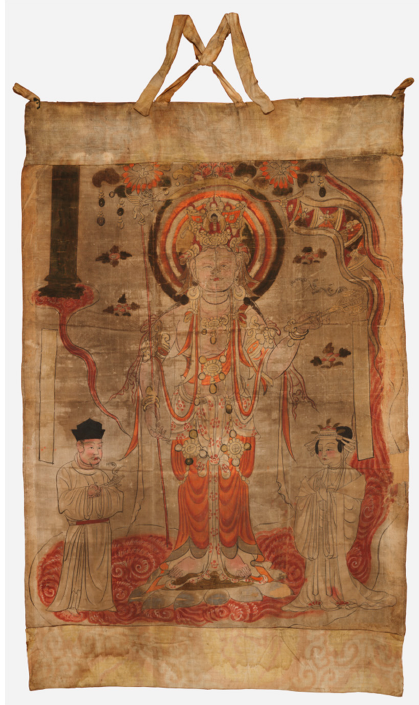
Figure 12. Soul-Guiding Bodhisattva . Dunhuang, 9th century . Ink and colors on silk, 80.5 × 53.8 cm . The British Museum (1919,0101,0.47) © The Trustees of the British Museum.